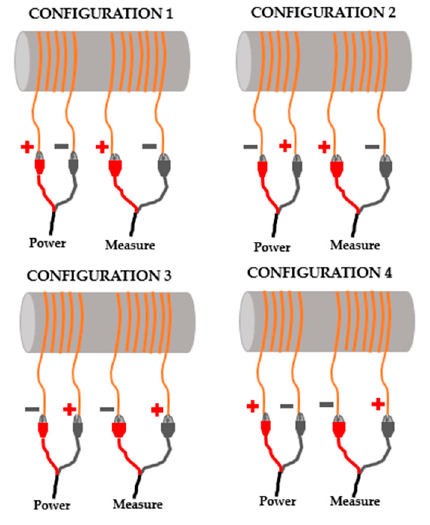
Figure 6. Different modes and configurations to measure Vout, tested in calibration and verification. Figure 6. Di ff erent modes and configurations to measure Vout, tested in calibration and